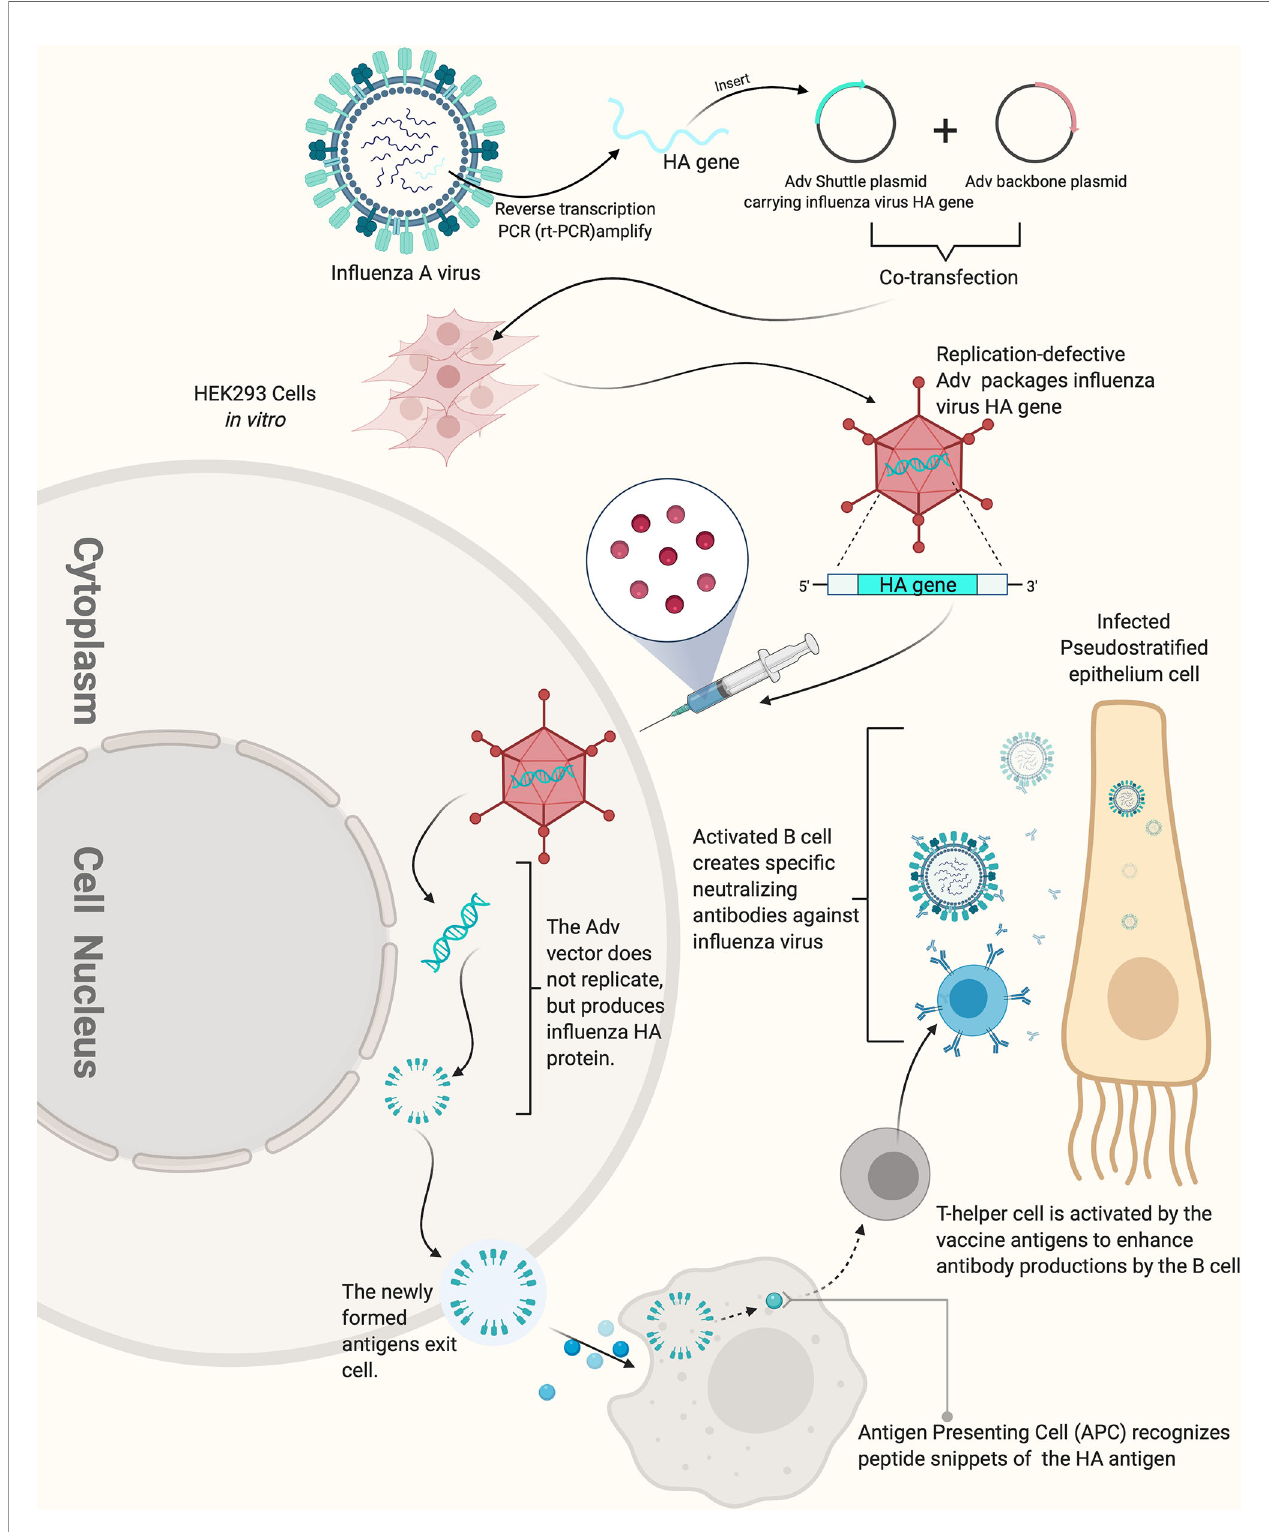
FIGURE 2 | How replication-defective adenovirus vector in fl uenza vaccine works. The replication defective adenovirus vector carrying the HA gene of in fl uenza virus can induce the production of high-titer HI antibody. The fi gure was created with Biorender.com.